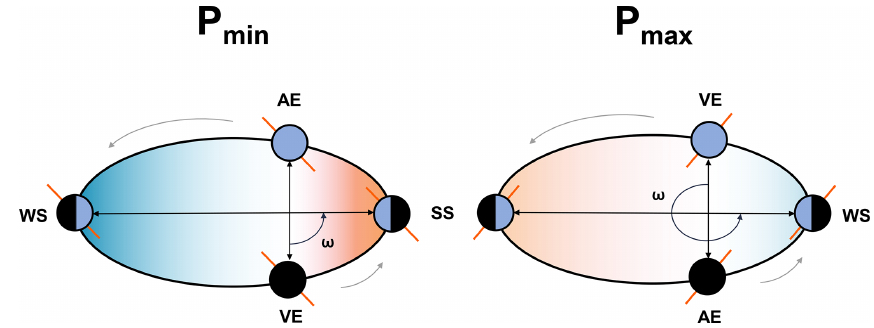
Figure 1. The schematic diagram showing the orbital configuration of minimum precession ( P min ) and maximum precession ( P max ). In P min , summer solstice (SS) occurs at perihelion, while in P max , winter solstice (WS) coincides with the perihelion. AE and VE are the autumn and vernal equinoxes, respectively. Table 1. The orbital configuration used for the extremes in precession, precession minima P min , precession maxima P max , and the pre- industrial. “ e ” represents eccentricity, δ is the tilt, and ω is the longitude of perihelion. The values of these have been chosen based on the extremes in the precession parameter e ∗ sin( π + ω ) that have occurred in the last 1Myr (Berger, 1978). Pre-industrial values are shown for comparison.